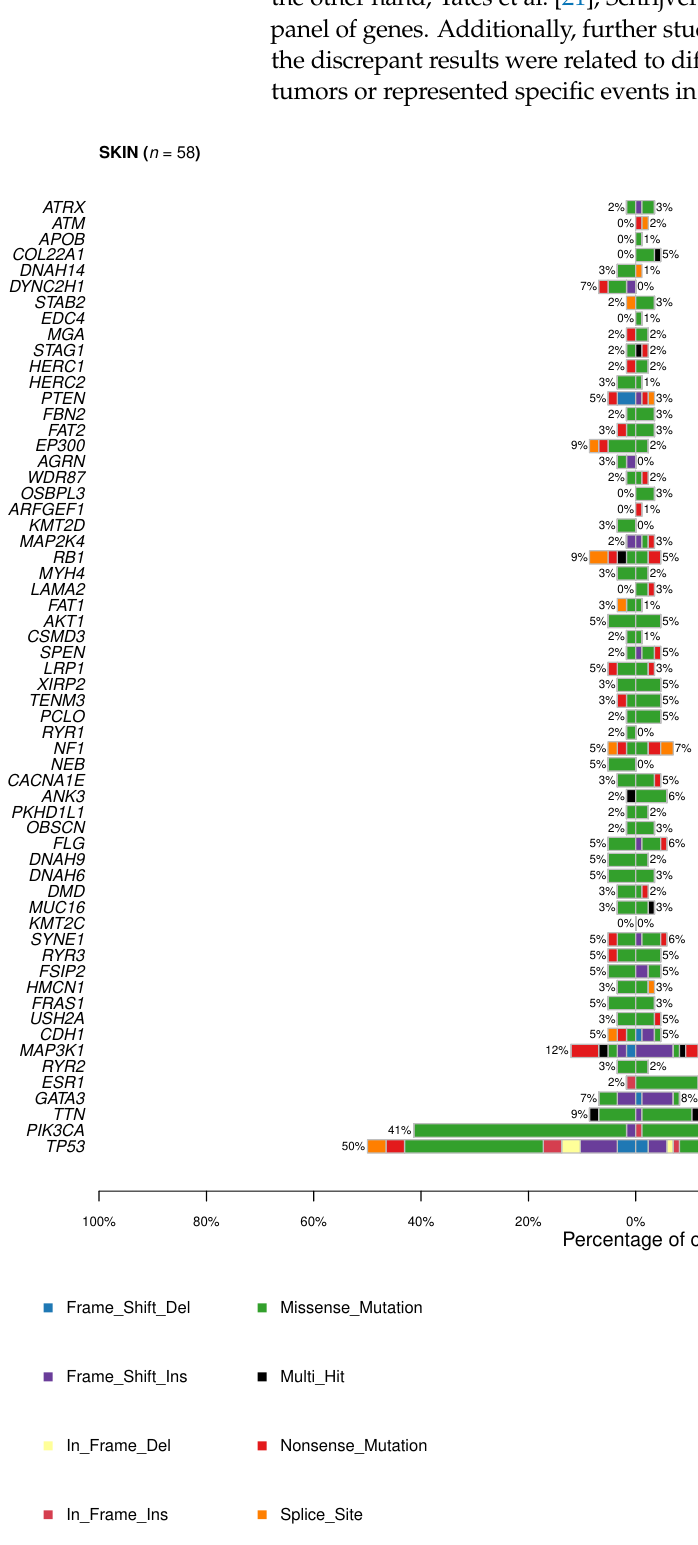
Figure 7. Type and frequency of mutations in cutaneous and liver metastases according to